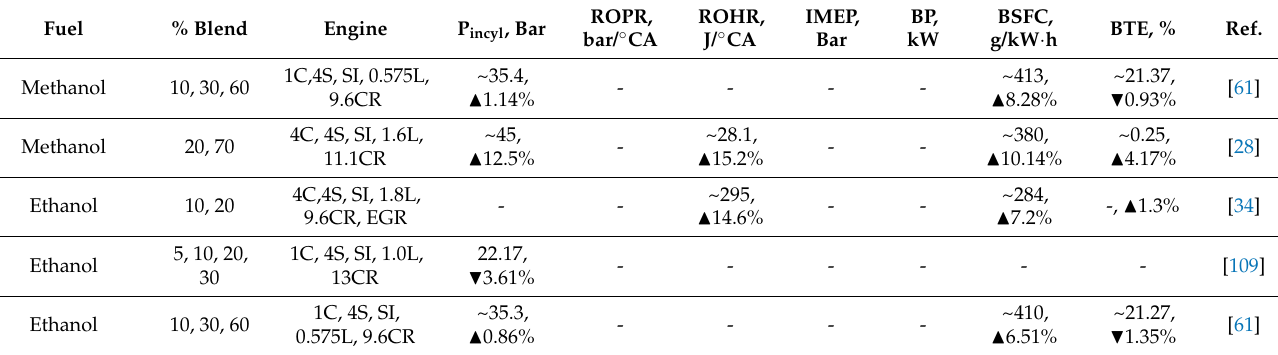
Table 4. Previous findings with alcohol and alcohol–gasoline blend